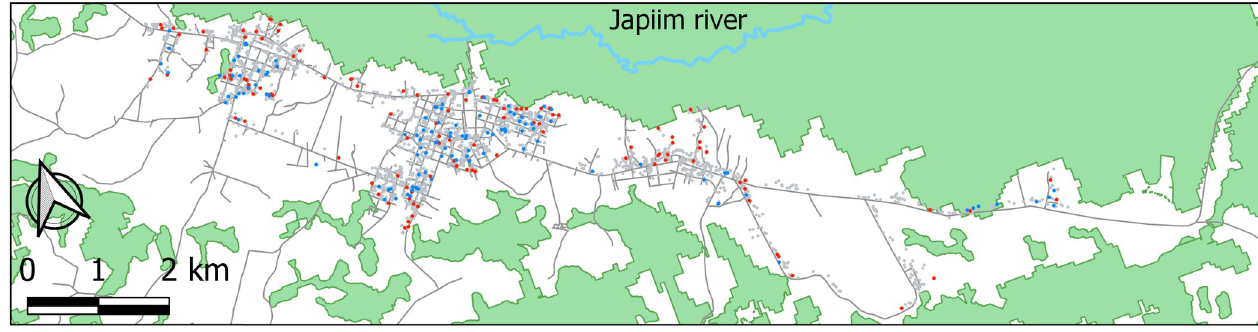
Fig 3. Spatial distribution of households and malaria incidence in urban Maˆncio Lima, northwestern Brazil.